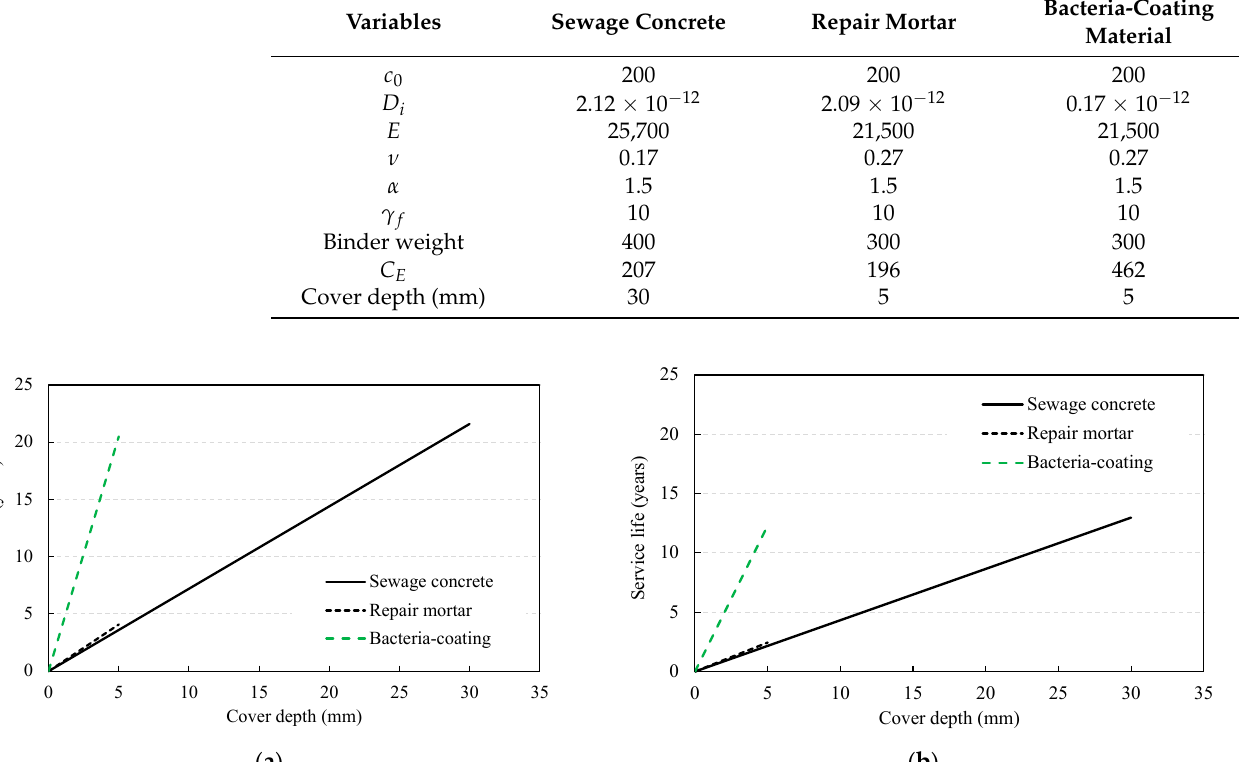
Table 6. Analysis conditions on service life evaluation (Deterministic method).